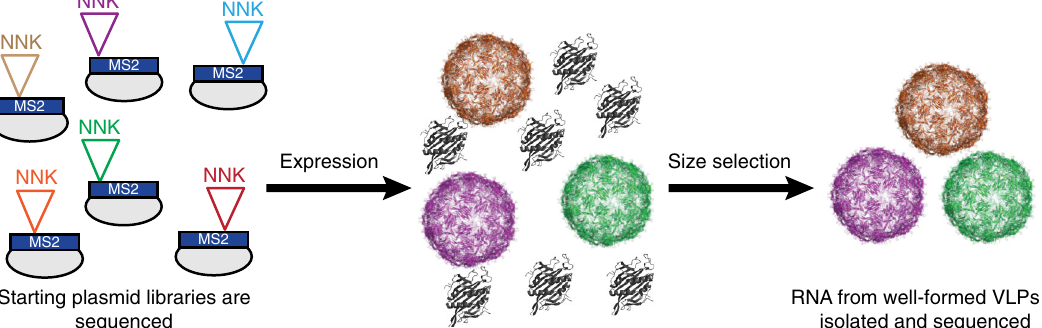
Fig. 1 The SyMAPS approach to understanding VLP self-assembly. The NNK codon = (Any)(Any)(G/T), and results in the systematic incorporation of all 20 amino acids and a stop codon in each position of the sequence. FPLC SEC was used as a size selection, enriching for AFS (blue) indicate increased variant abundance following selection, while negative scores (red) indicate decreased abun- dance. Standard deviations were calculated across the three biological replicates (Supplementary Fig. 2).